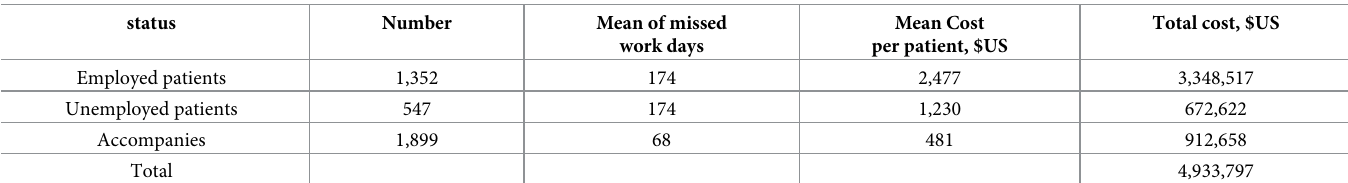
Table 4. The indirect costs of disability and absence from work due to oral cancer in Iran in 2014.